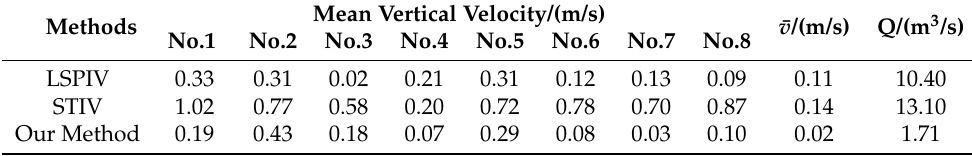
Table 8. Absolute error